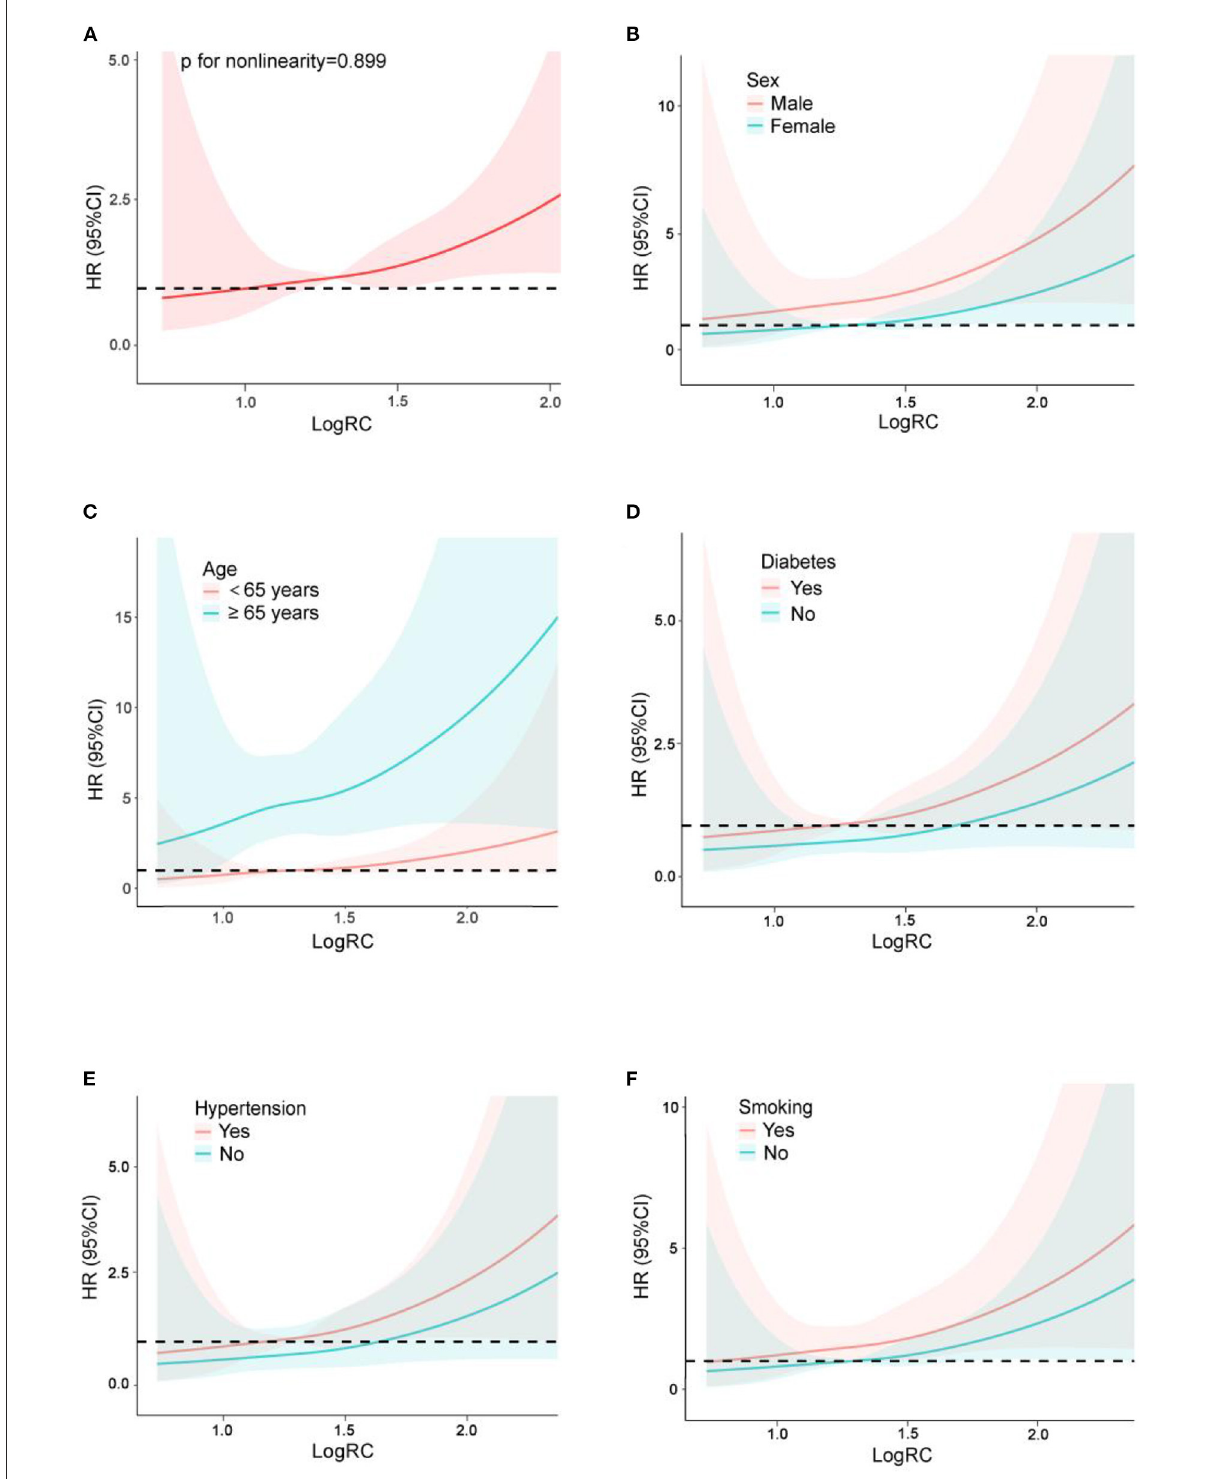
FIGURE2 Restricted cubic spline plots of the association between log 10 -transformed RC and cardiovascular mortality in the general population (A) and subgroup analysis by sex (B) , age (C) , diabetes (D) , hypertension (E) and smoking (F) . Analysis was adjusted for age + sex + race + antihypertensive medications + lipid-lowering medications use + systolic blood pressure + coronary heart disease + stroke + smoking. HR, hazard ratio; CI, confidence